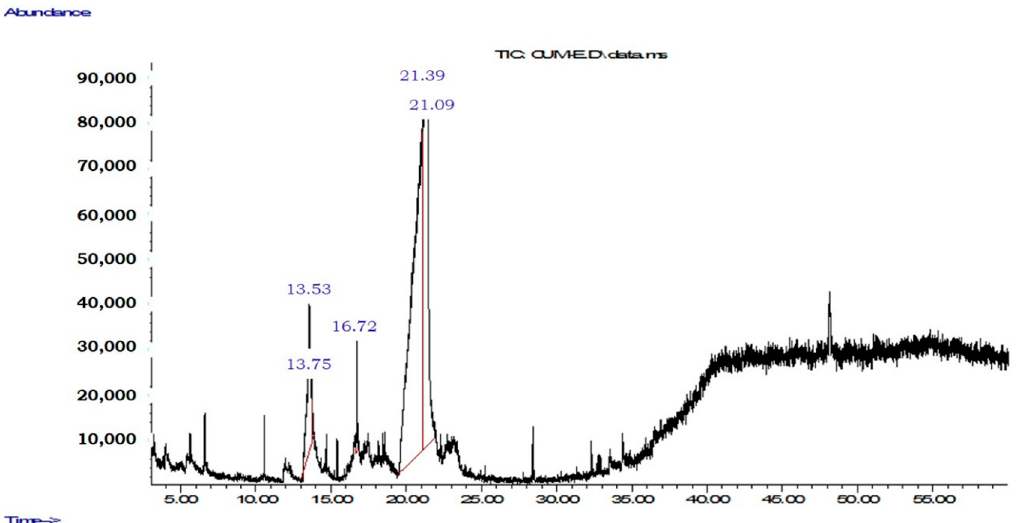
Figure A8. Dipteryx punctata endocarps extract chromatogram.